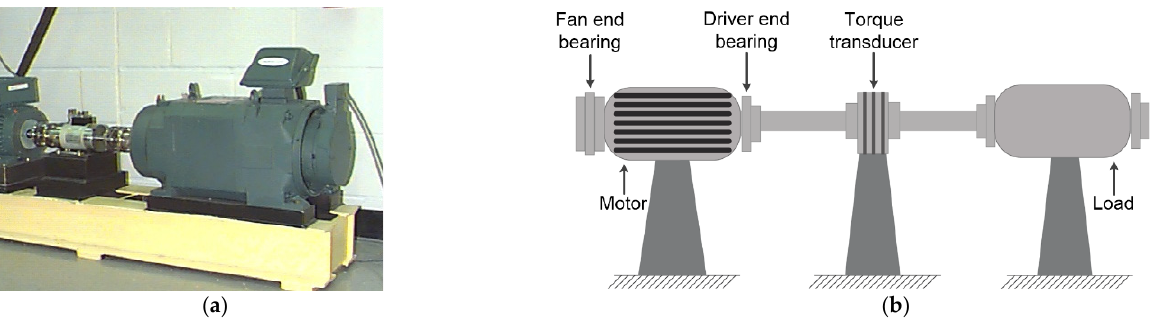
Figure 4. The motor-bearing test bench of CWRU: ( a ) real-life diagram of test rig; ( b ) structure schematic diagram of test rig.